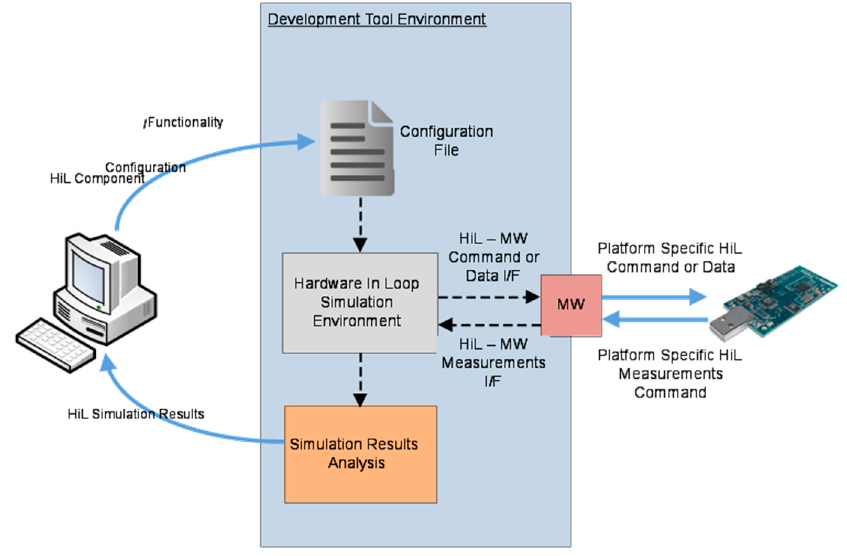
Figure 14. Interaction flow between the HiL Component and the hardware node.